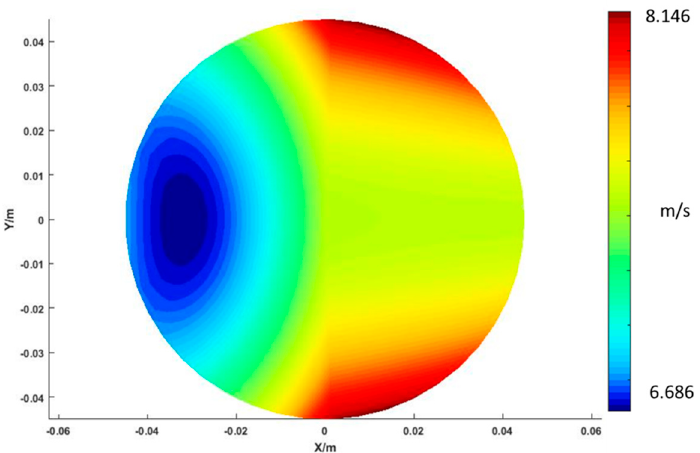
Figure 6. Calculation results of the relative velocity distribution for polishing parameters at α = 9°, ω p = 500 RPM, D = 90 mm, R = 175 mm, f = 10 Hz, θ = 24°.